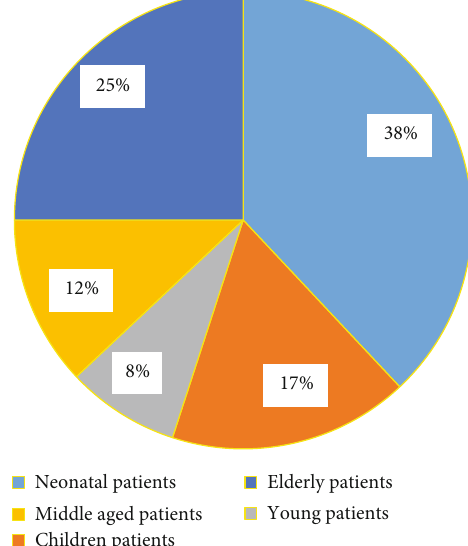
Figure 1: Visual diagram of proportion results of neonatal treatment